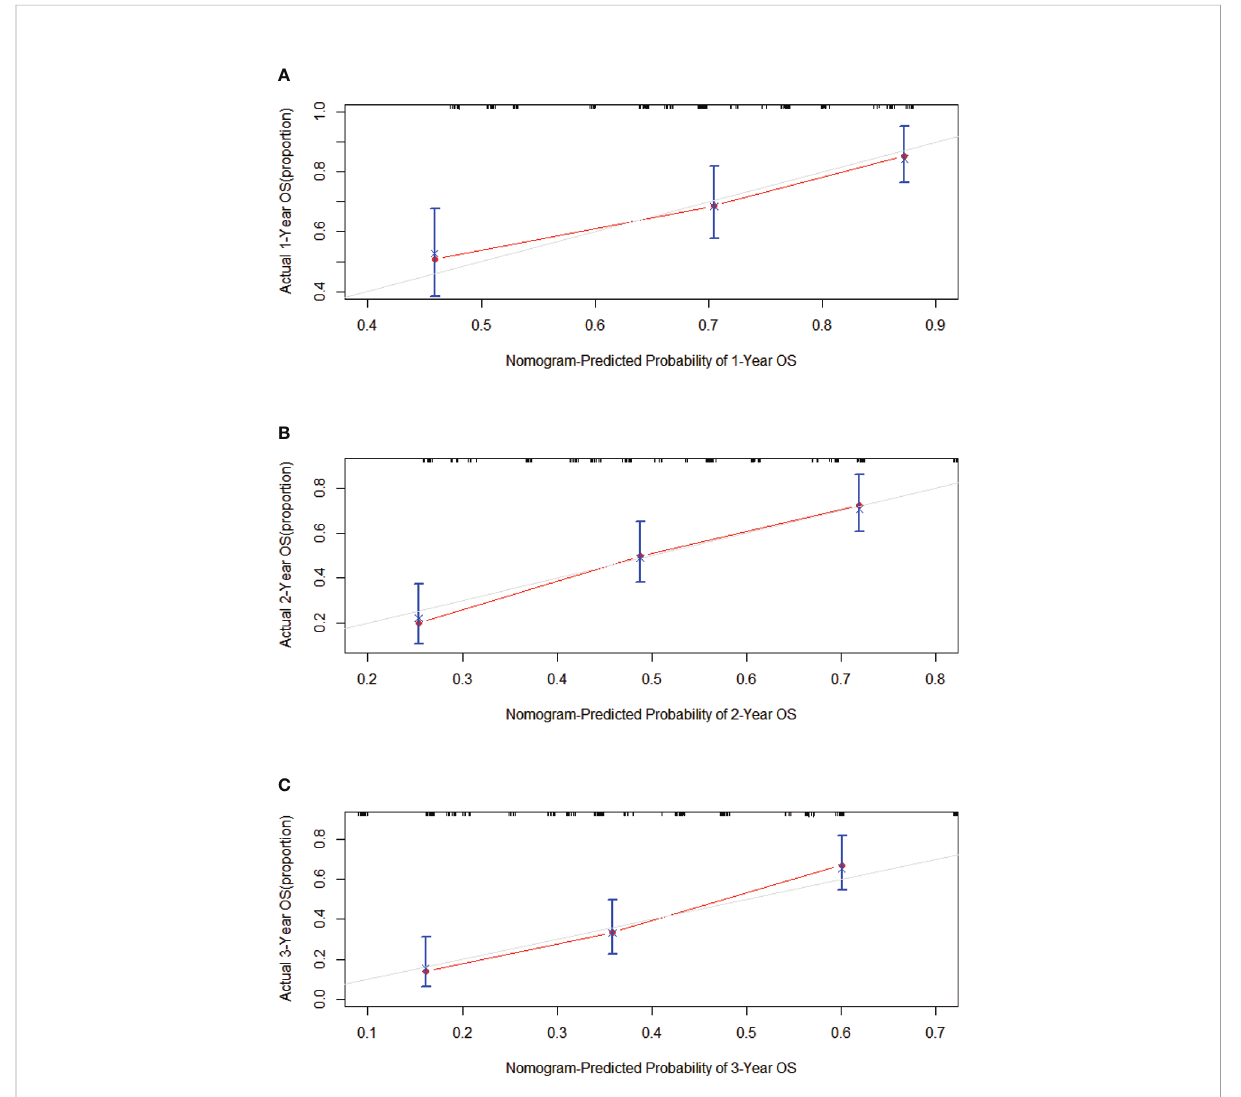
FIGURE 3 Calibration curves predicting the (A) 1-, (B) 2-, and (C) 3-year OS of patients in the training cohort. On the x-axis are the predicted survival probabilities, and on the y-axis are the actual survival probabilities. There is an agreement between the prediction and reality based on the 45° line (gray